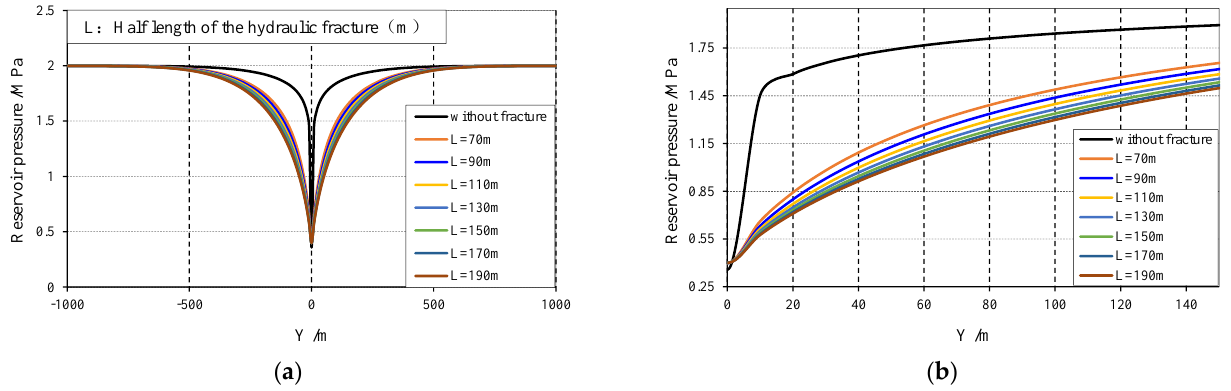
Figure 11. The reservoir pressure when different fracture lengths of each point on the profile line 1 after mining for 5 years. ( a ) the whole profile line, and ( b ) a part of profile line 1. The CBM concentrations for different hydraulic fracture lengths are also